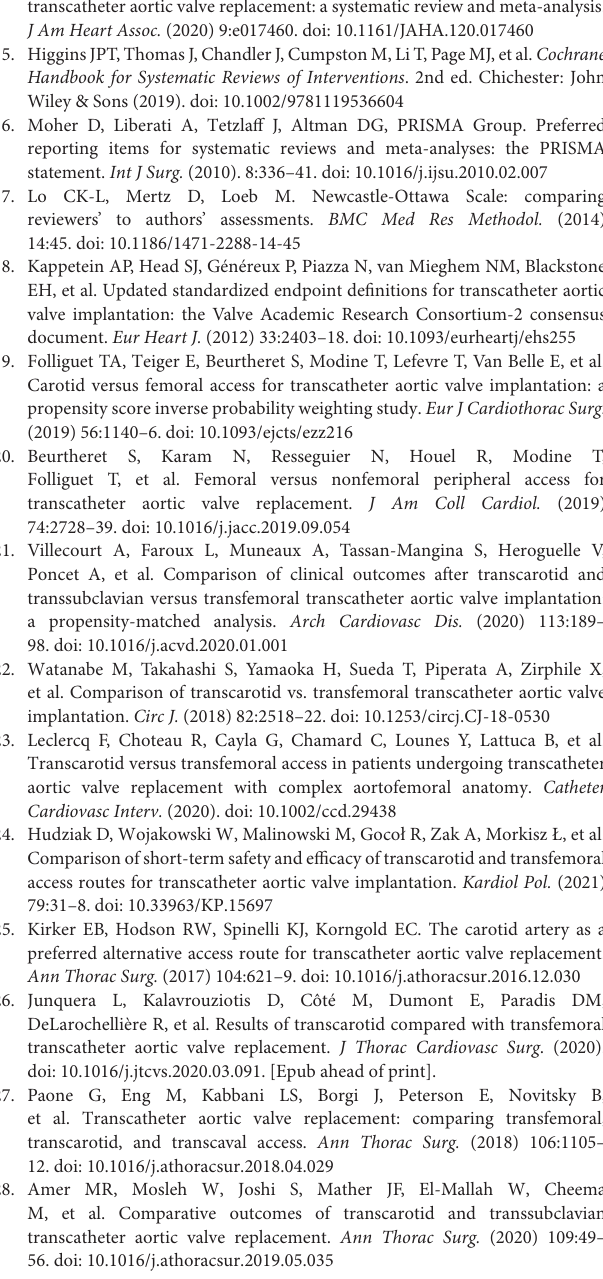
Supplementary Figure 1 | Funnel plots for assessment of publication bias in each outcome. Supplementary Table 1 | Search term strategy.